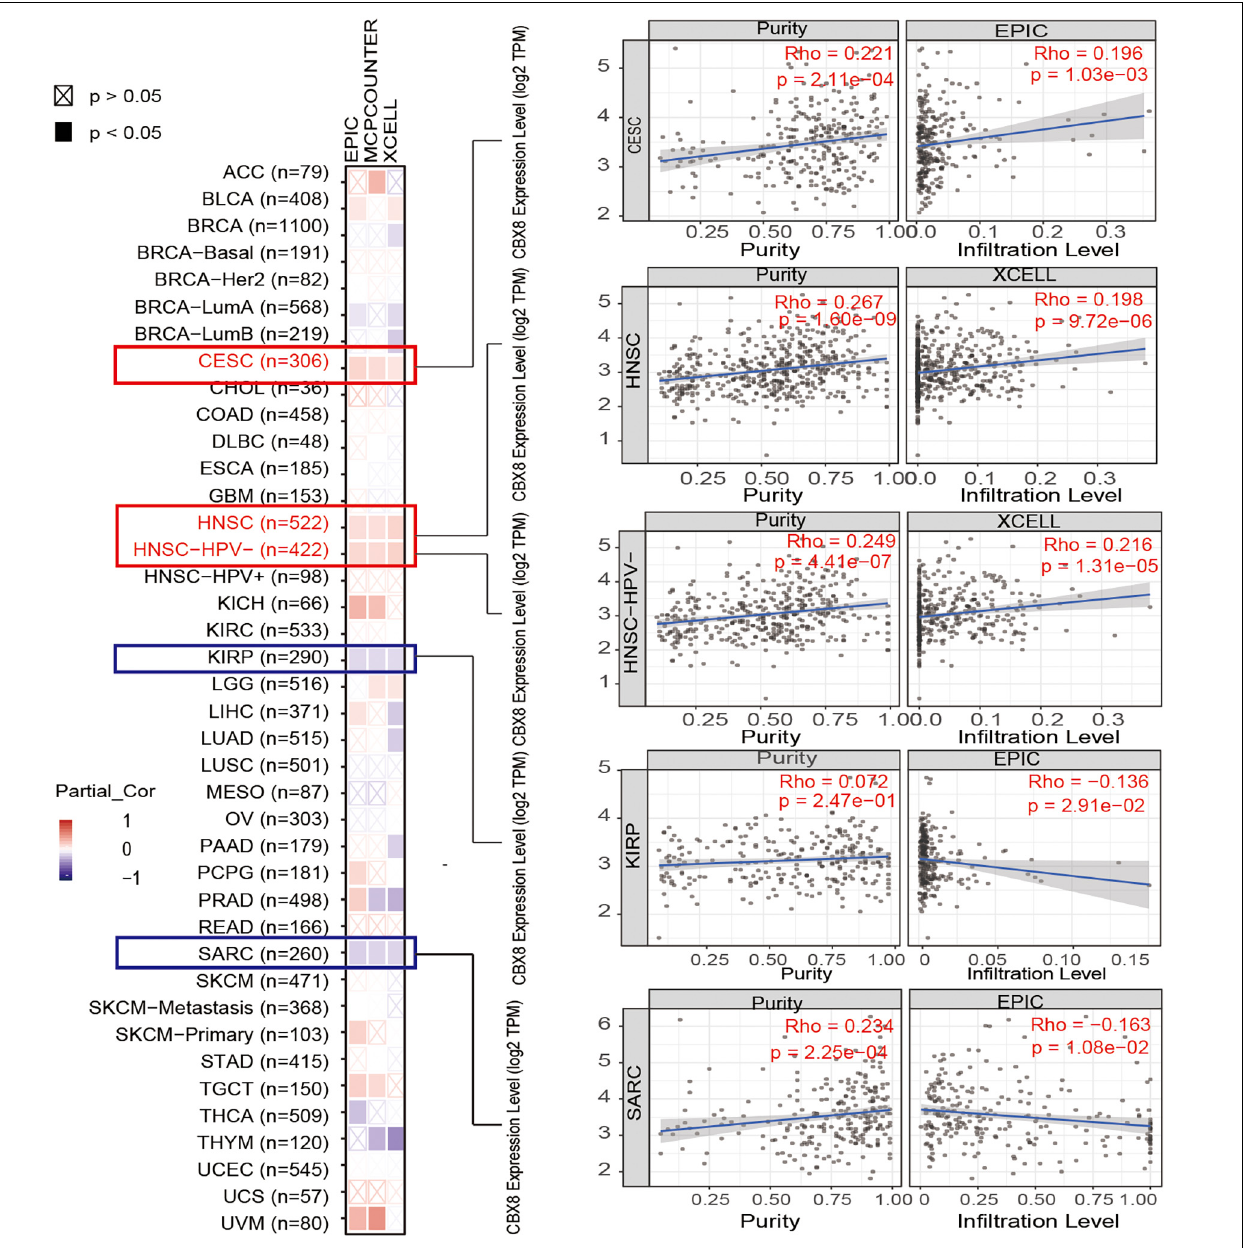
FIGURE 5 | Correlation analysis between CBX8 expression and immune infiltration of cancer-associated fibroblasts. For all types of cancer in TCGA, the correlation between CBX8 expression and immune infiltration of cancer-associated fibroblasts evaluated by different algorithms, including EPIC, MCPCOUNTER, and